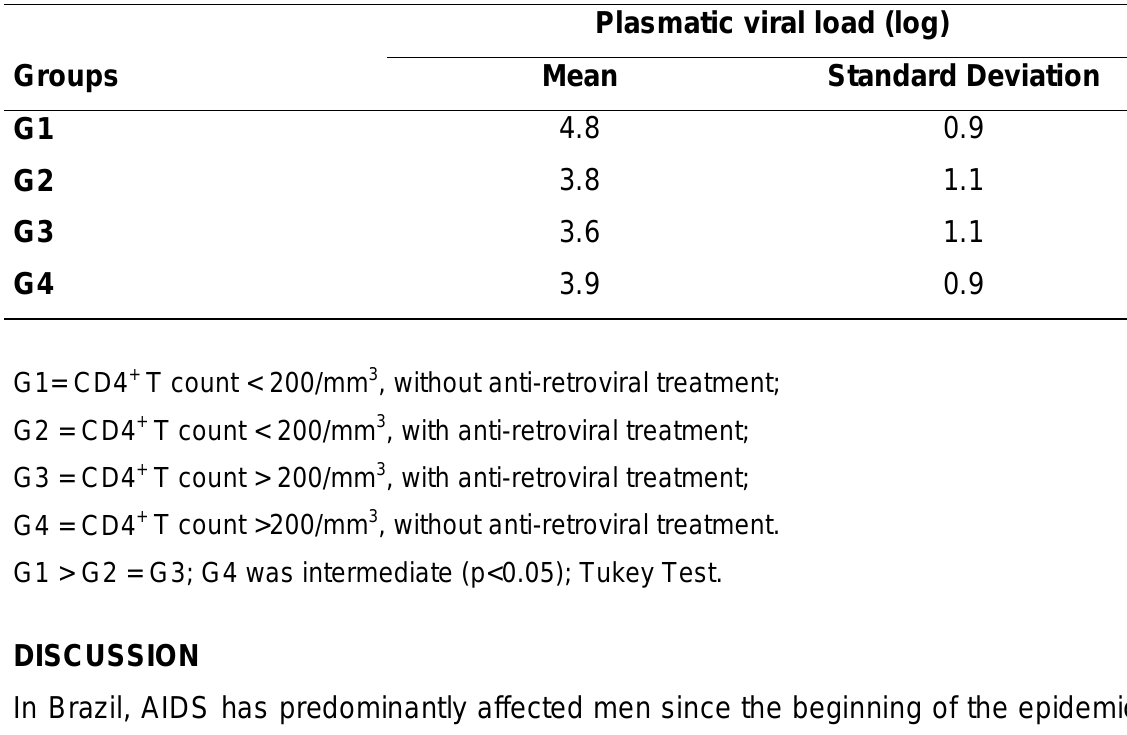
Table 3. Distribution of HIV plasmatic viral load according to means and standard deviations of log 10